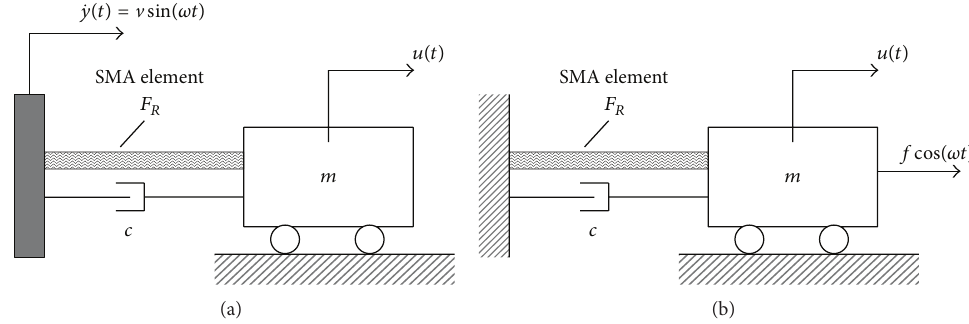
Figure 1: Single degree of freedom oscillator: (a) harmonic base excitation and (b) harmonic force applied to the mass.